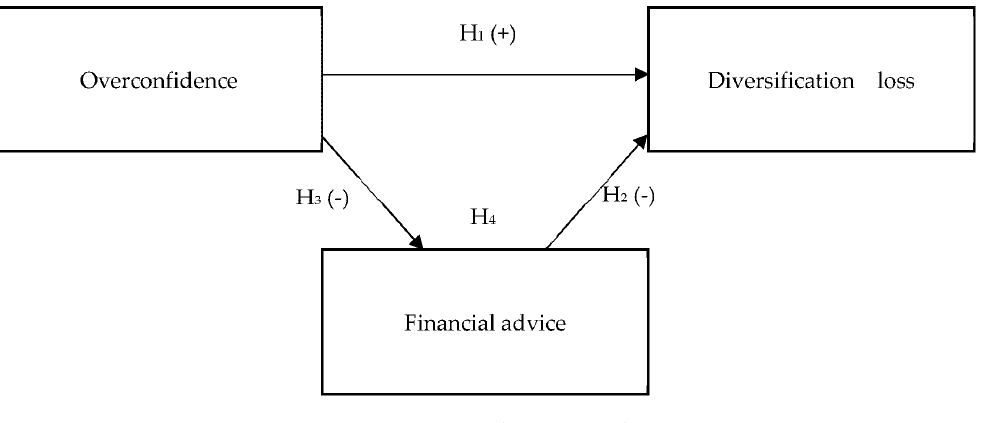
Figure 1. Research Framework.